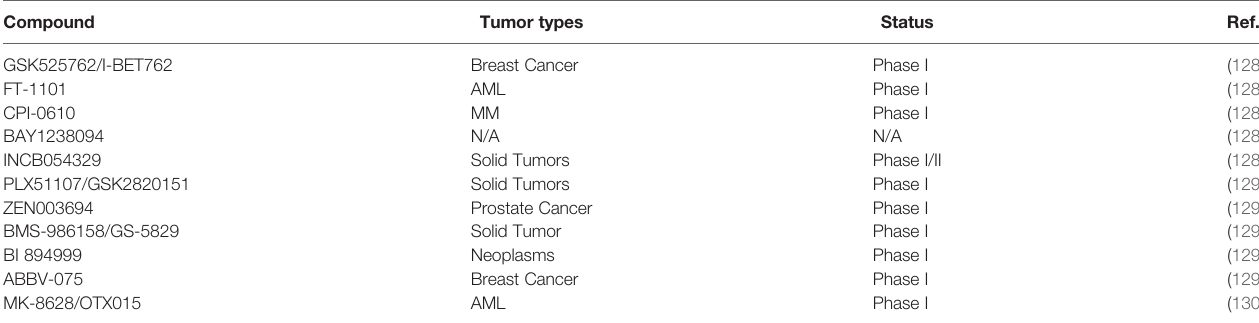
TABLE 4 | BRD-extraterminal proteins inhibitors (BETi) display the roles against tumors. Compound